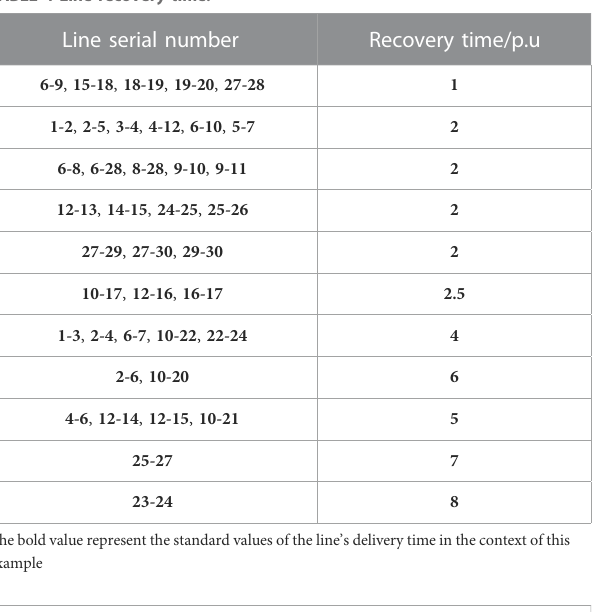
TABLE 4 Line recovery time.